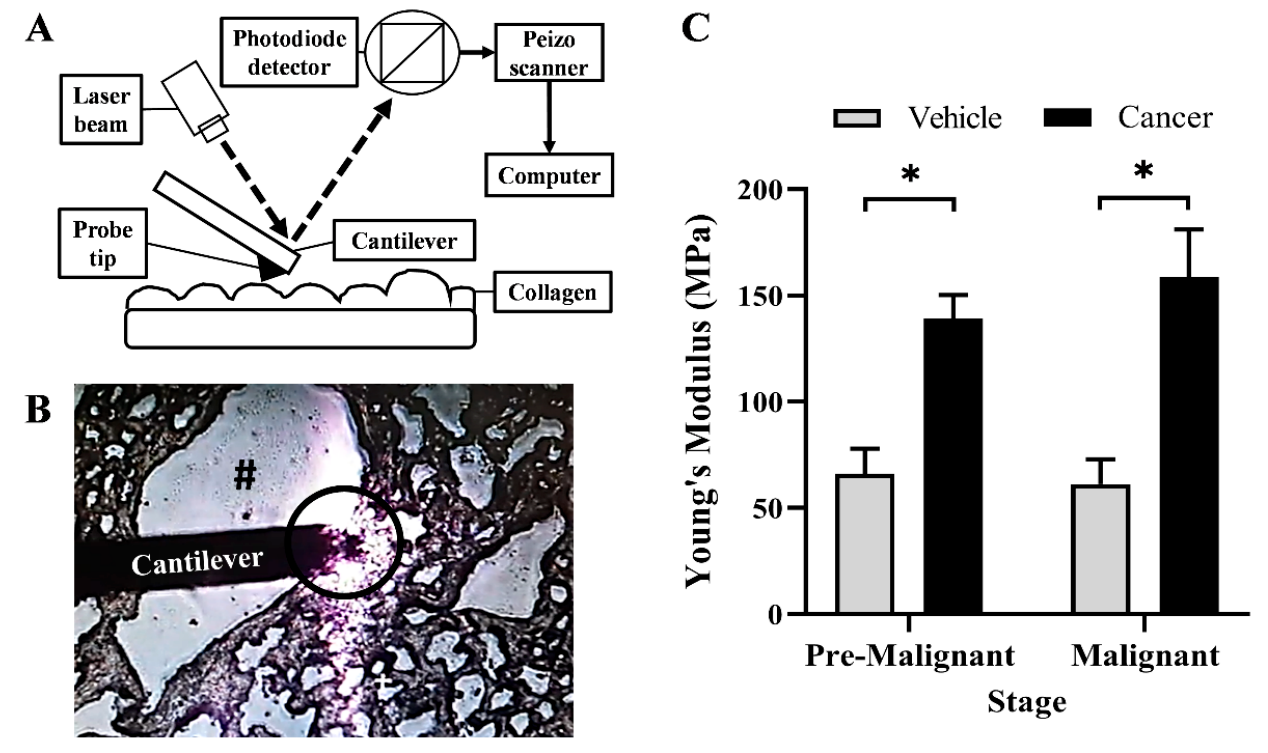
Figure 4. ( A ) The components of the standard atomic force microscopy that works by reflecting the laser focused on the cantilever, which is then captured by the scanner and measured as Young’s modulus by the computer software. ( B ) The aerial view of the working cantilever at a bronchial area where the measurement of collagen rigidity was taken. # shows the bronchial airway. The circle shows the area of the probe tip, which measured the collagen rigidity. ( C ) The bar chart of Young’s modulus (MPa) at the bronchial area of the Vehicle and Cancer group from both stages of carcinogenesis. Data are presented as mean ± SEM. * is a significant difference ( p < 0.05) between the Vehicle and Cancer groups in the same stage of carcinogenesis. p < 0.05 using Student’s t -test.